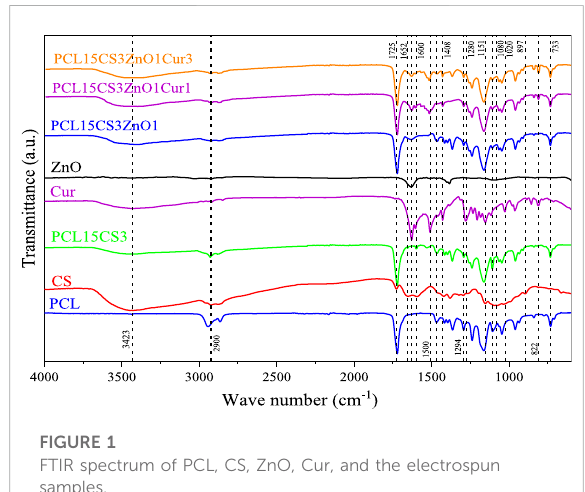
FIGURE 1 FTIR spectrum of PCL, CS, ZnO, Cur, and the electrospun